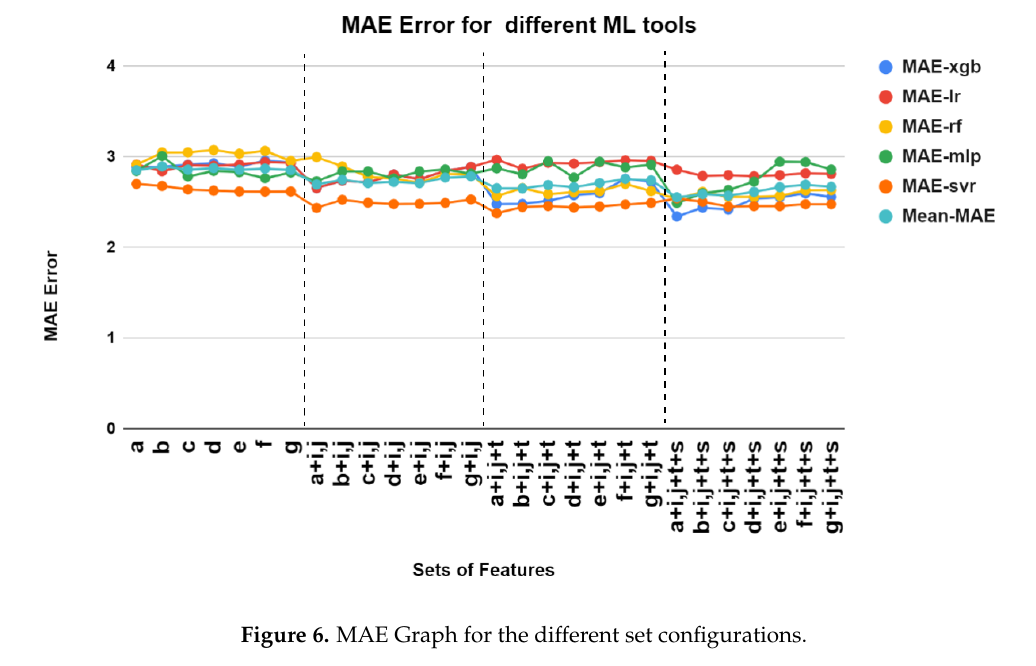
Figure 6. MAE Graph for the different set configurations.